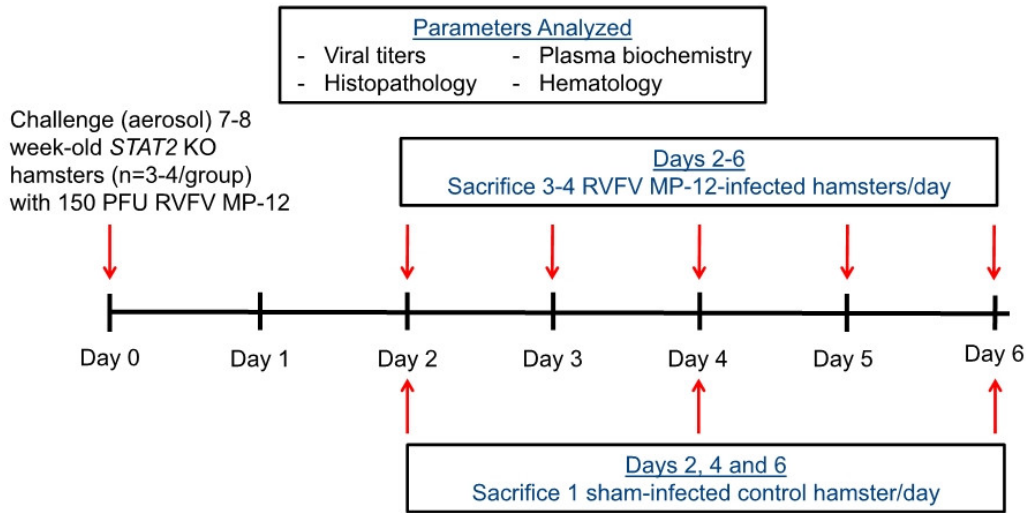
Figure 1. Pathogenesis study design of aerosolized Rift Valley fever virus (RVFV) MP-12 infection in STAT2 KO hamsters.